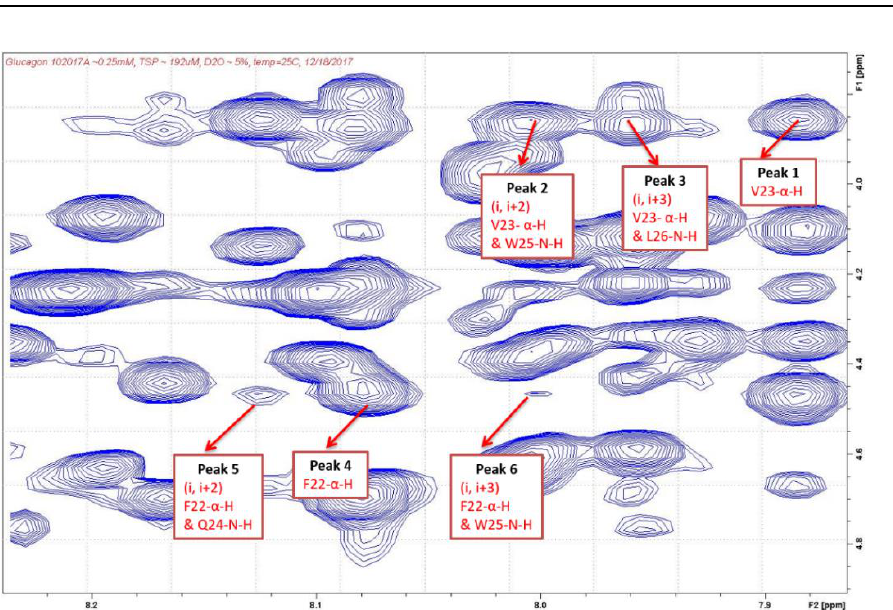
Figure 3. NOESY cross-peaks in AMP-glucagon.